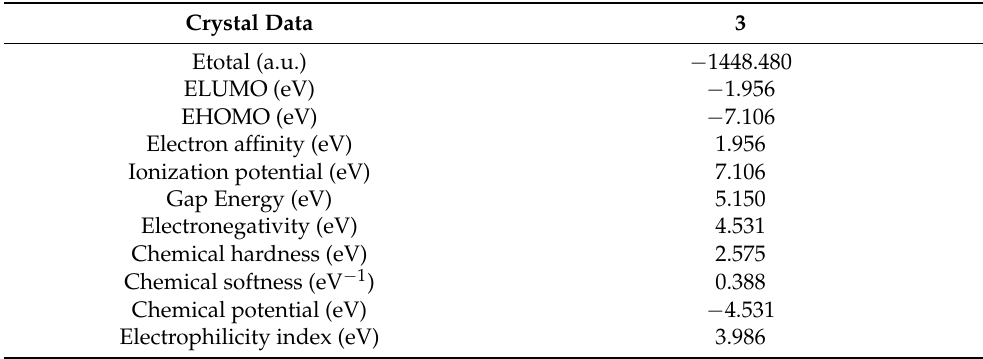
Table 3. HOMO-LUMO energies and values of quantum chemical parameters calculated at PBE1PBE/cc-pVDZ level of